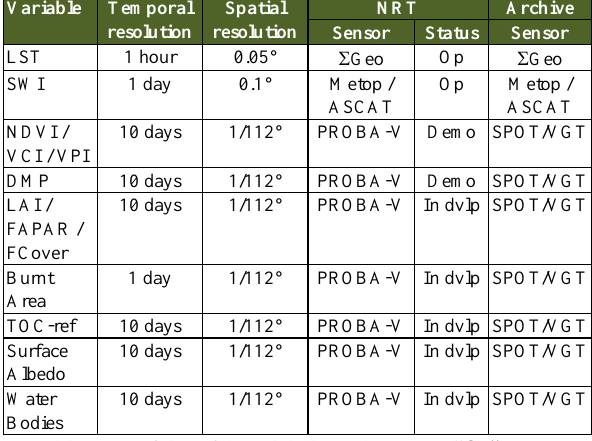
Table 1: Portfolio of the Global Land Service. “Op” means “operational”, “demo” means “Demonstration”, “In dvlp” means “in development”.